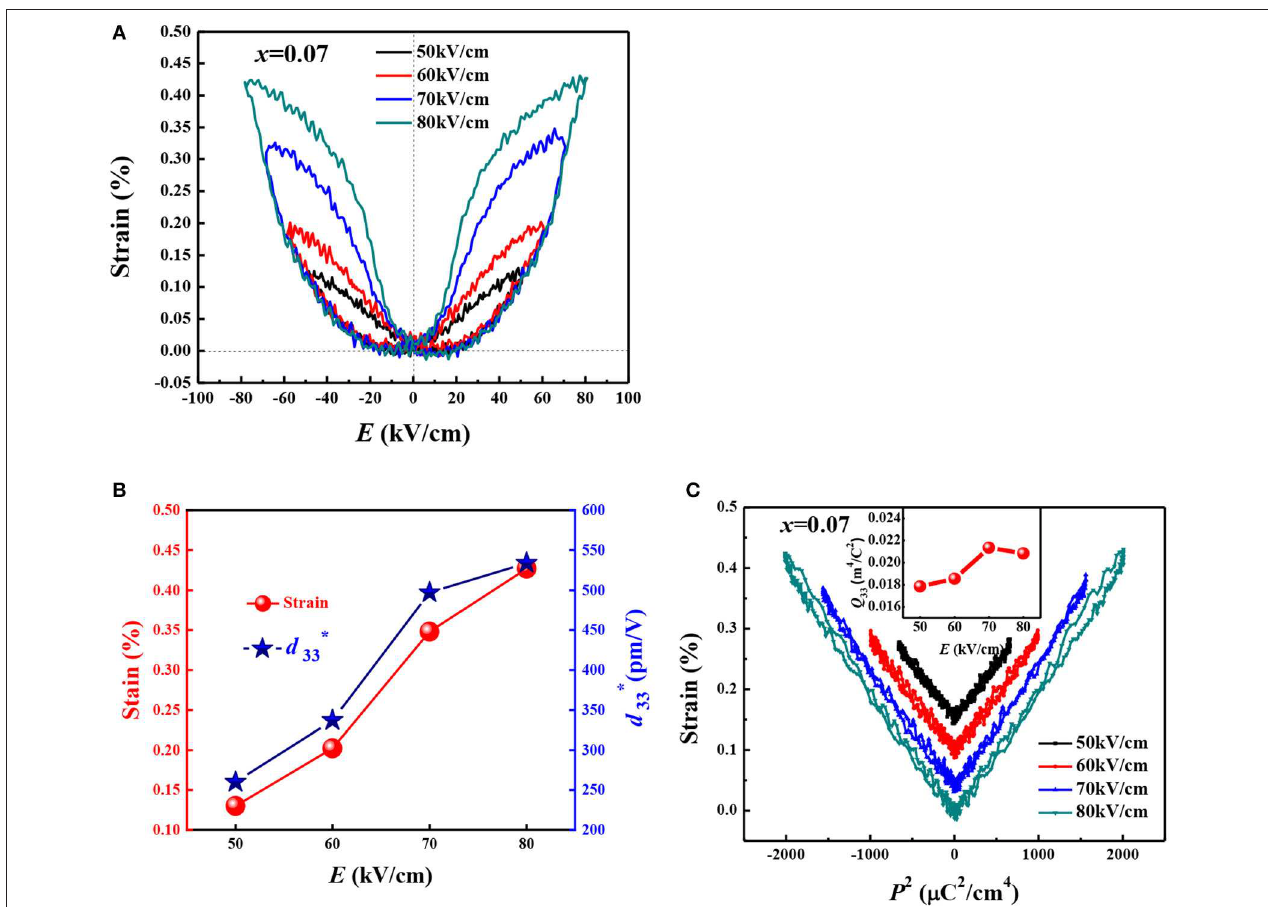
FIGURE 6 | (A) Bipolar strain loops, (B) Maximum strain and d 33* and (C) S - P 2 loops of BNKT-0.07FSN ceramic under different electric fields and the inset shows Q 33 as the function of different external electric